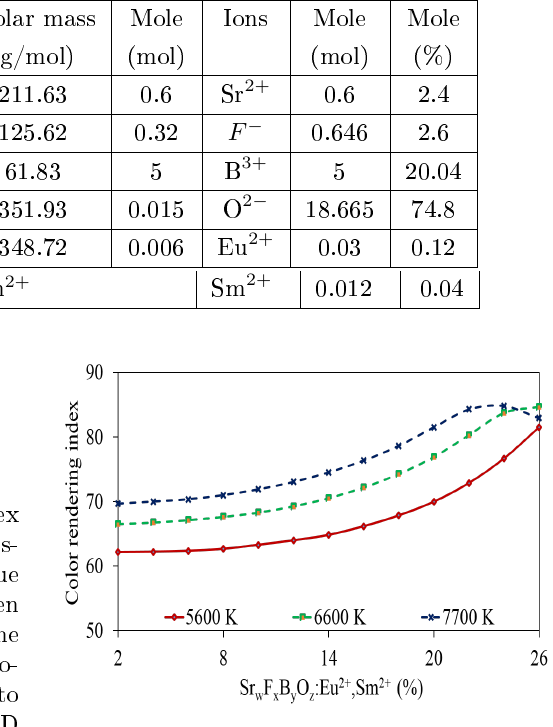
Fig. 3: The color rendering index of WLEDs as a func- tion of Sr w F x B y O z :Eu 2+ , Sm 2+ concentration.